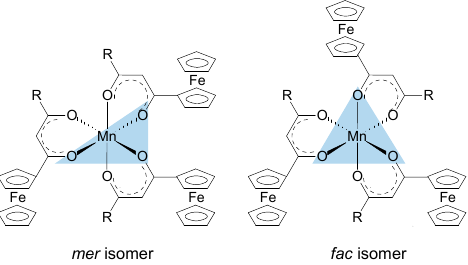
Figure 4. Mer and fac isomers of [Mn(FcCOCHCOR) 3 ] complexes containing an unsymmetrically substituted β -diketonato ligand, R = CF 3 ( 1 ), CH 3 ( 2 ), C 6 H 5 ( 3 ).